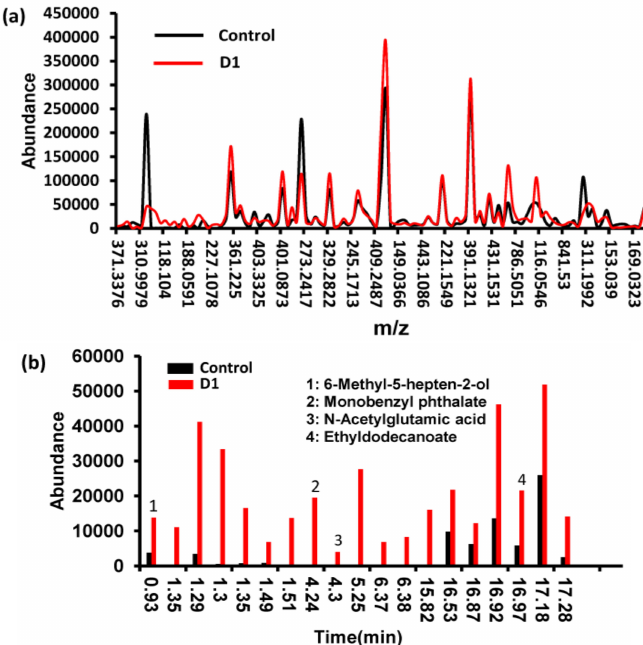
Figure 5. Detection of water-soluble products by LC-MS at the end of 31 days of cultivation. ( a ) Comparison of the abundance of compounds eluted at the same M / Z between the control group and the D1-treated group. ( b ) Increased abundances of acids, esters, and alcohols were observed in the D1-treated group compared with the control